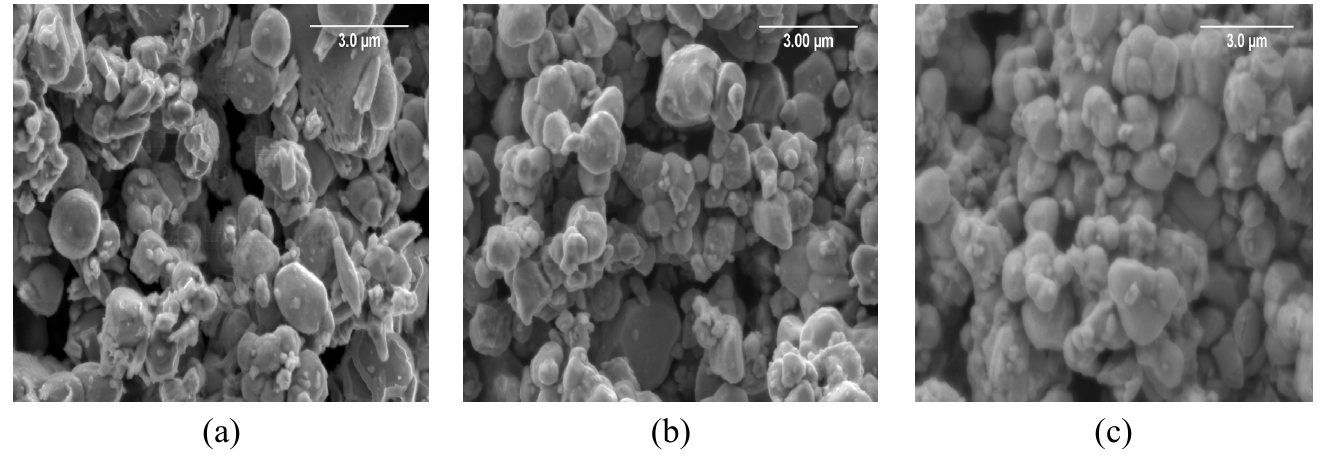
Figure 3. SEM images of the polycrystalline powders: BMW ( a ), BMW-Eu ( b ), and BMW-Nd ( c ).